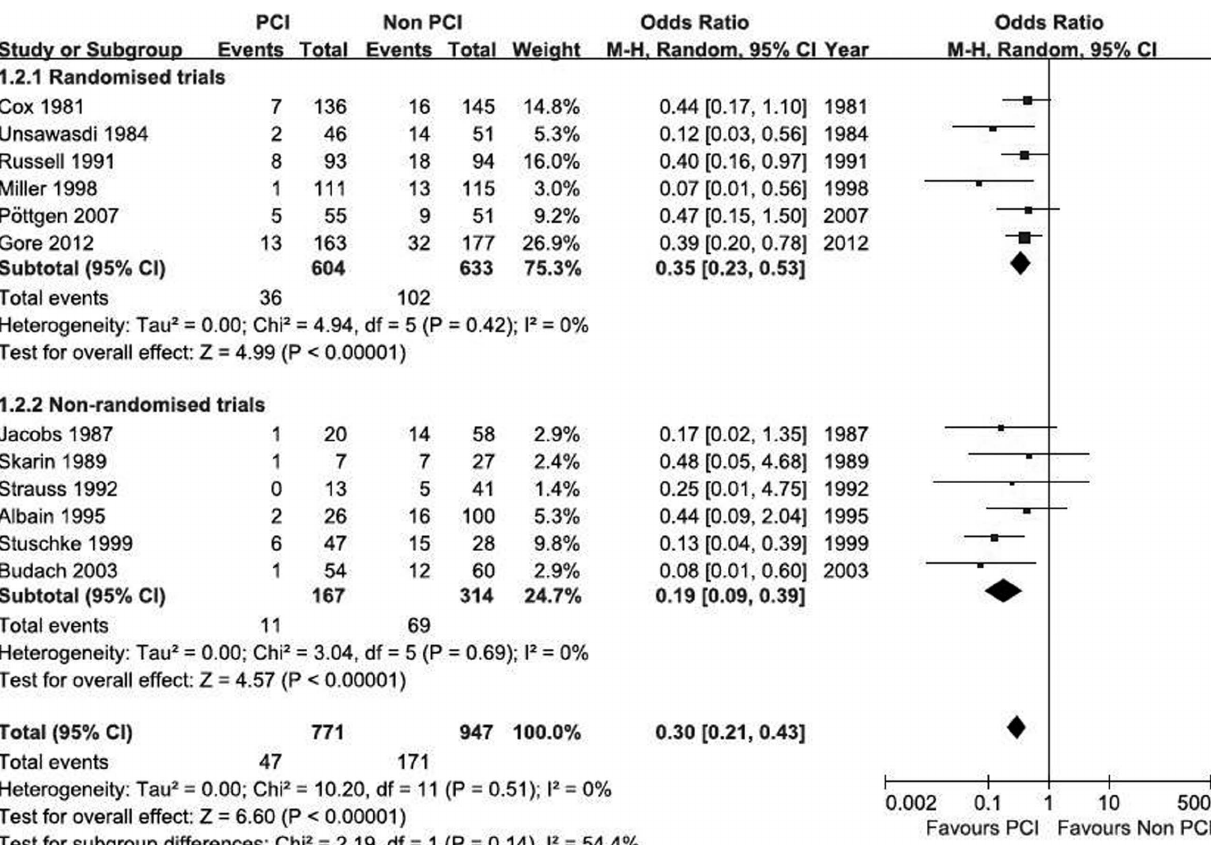
Figure 2. Results of the meta-analysis on studies evaluating the effect of PCI on brain metastases: OR: 0.30 (95% CI: 0.21–0.43).